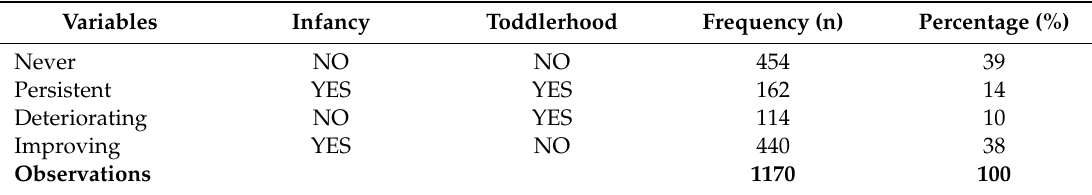
Table A5. Evolutionary path from infancy to toddlerhood.